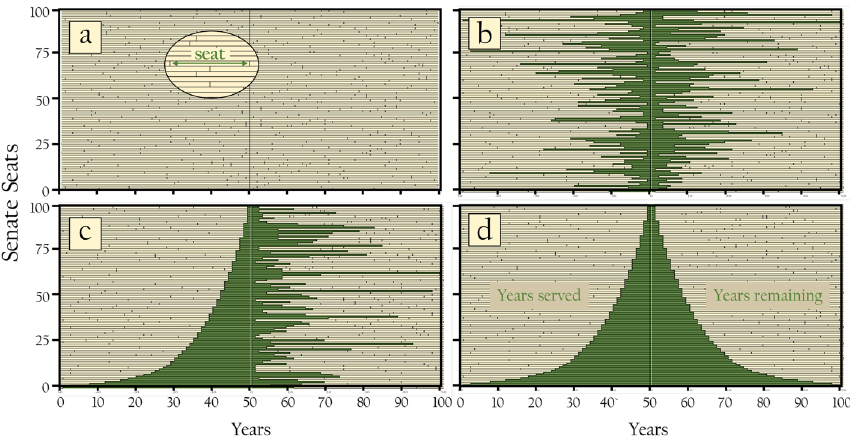
Fig. 1 Depiction of horizontal lifelines for a hypothetical 100-member Senate for one century. Each horizontal line represents a seat with interspersed green ticks depicting a change-of-seat. The solid green lines depict the years served by individual members who were jointly serving in year 50 (i.e., current hypothetical year). a Hypothetical 100-seat “lanes” with inset showing in-office duration of one member for approximately 20 years; b random vertical distribution of lifelines for current members; c lifelines of current members ordered shortest-to-longest from top-to-bottom according to years already served; d lifeline segments of current members for years served and years remaining decoupled and each ordered shortest-to-longest from top-to-bottom. Note the mirror-image symmetry of the two